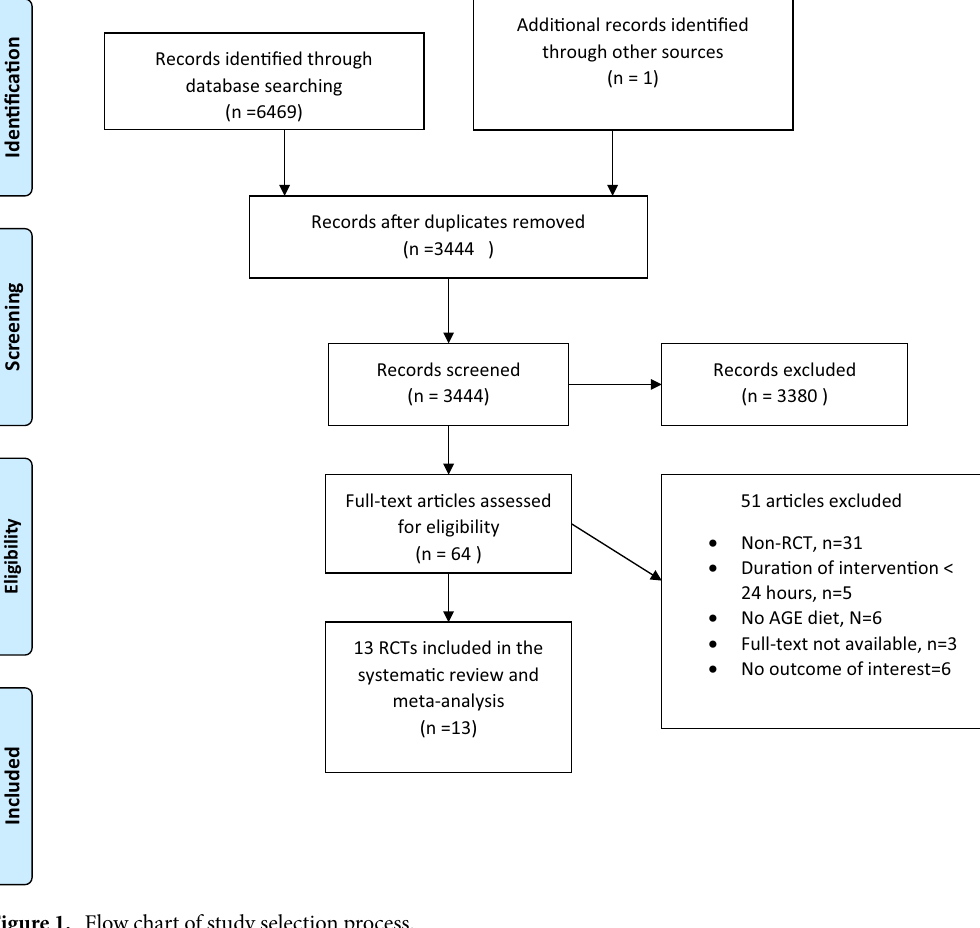
Figure 1. Flow chart of study selection